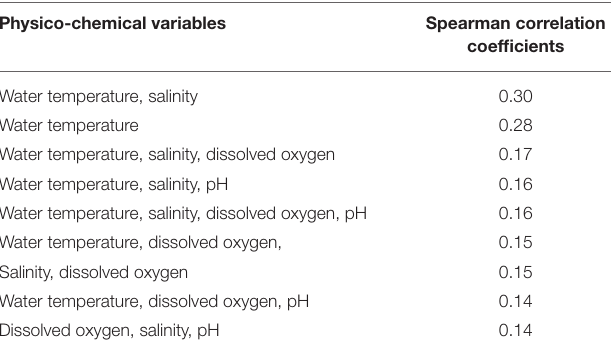
TABLE 2 | Results of Bio-Env analysis in the BEST routine of PRIMER 6, showing the variation in the correlation coefficient with different subsets of physico-chemical